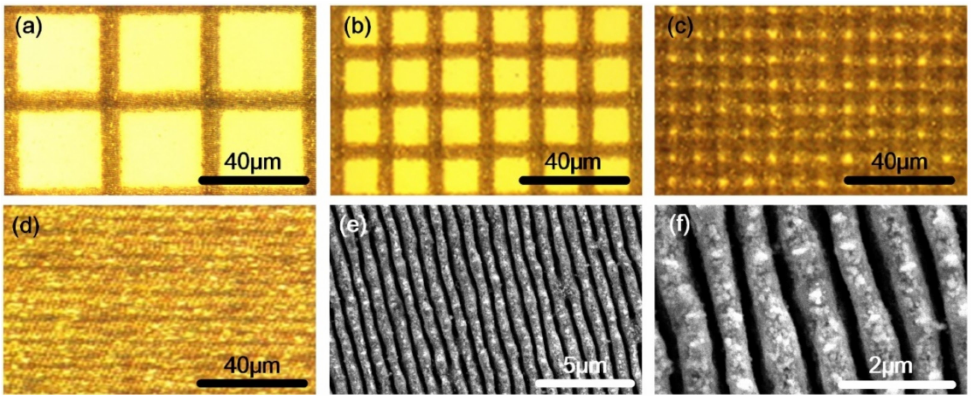
Figure 3. OM and SEM images of Si irradiated by a femtosecond laser at different scanning intervals. ( a – d ) OM images of a silicon wafer irradiated by a femtosecond laser at the laser power of 0.12 W and the scanning interval of 40, 20, 10, and 4 µ m, respectively. ( e , f ) SEM images of a silicon wafer irradiated by a femtosecond laser at the laser power of 0.12 W and the scanning interval of 4 µ m.